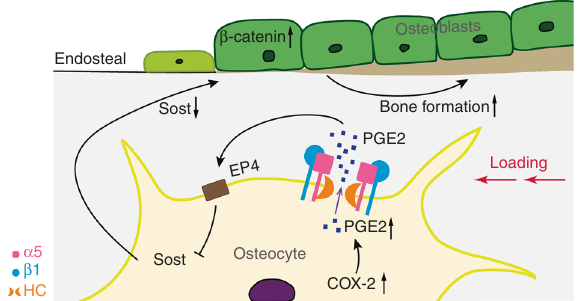
Fig. 8 Illustration of the role of osteocytic integrin a5 β 1 in anabolic response to mechanical stimulation in bone. Upon